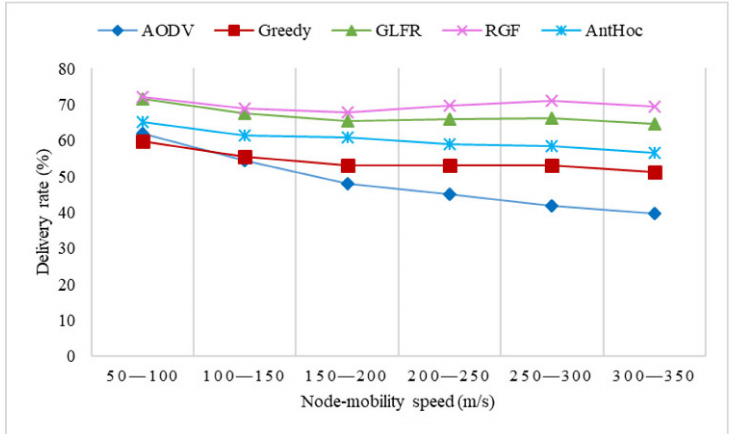
Figure 14. The effect of velocity on the delivery